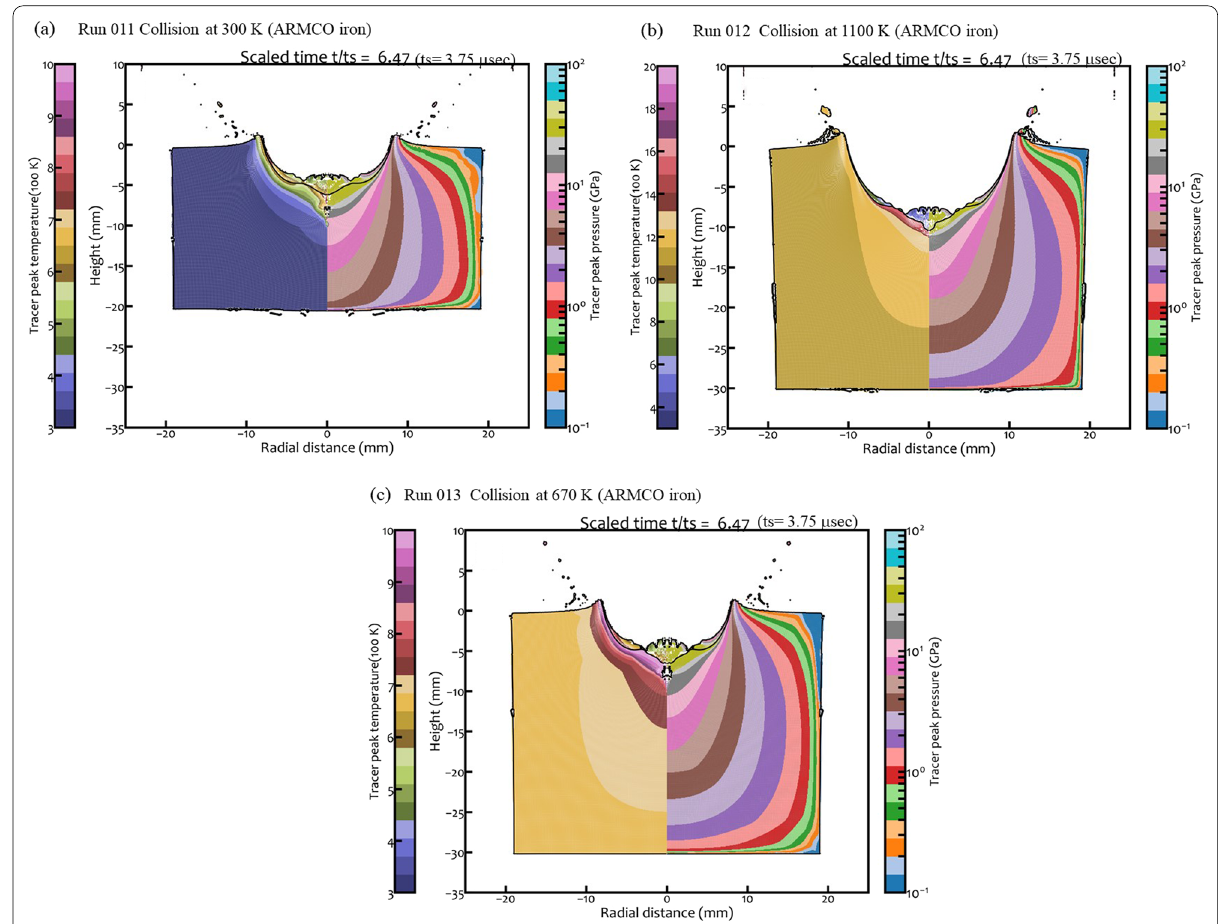
Fig. 10 The results of numerical simulations on distributions of the maximum temperature (left) and pressure (right) in the iron targets during the impacts at 300 K ( a ), 1100 K ( b ), and 670 K ( c ) corresponding to the experimental conditions of Run 011, 012, and 013. The color contour on the left side indicates the peak temperature, Kelvin, and that on the right side is the peak pressure in